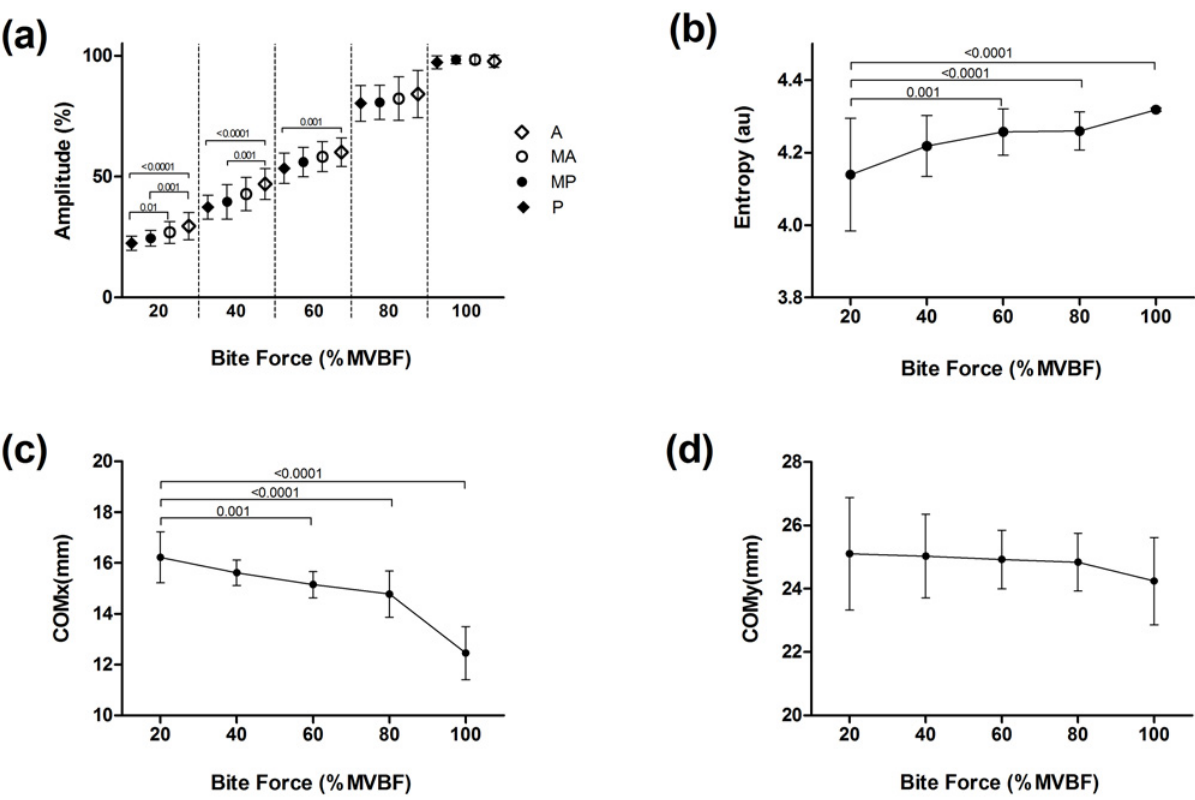
Figure 3. Masseter muscle electromyographic parameters at different levels of masticatory force. a) Amplitude in columns: Anterior (A), Middle- Anterior (MA), Middle-Posterior (MP) and Posterior (P). b) Values of entropy. c) Position of the center of mass in X. d) position of the center of mass in Y. The level of masticatory force is expressed as a percentage of MVBF. The differences are indicated by bars with their respective p-values.